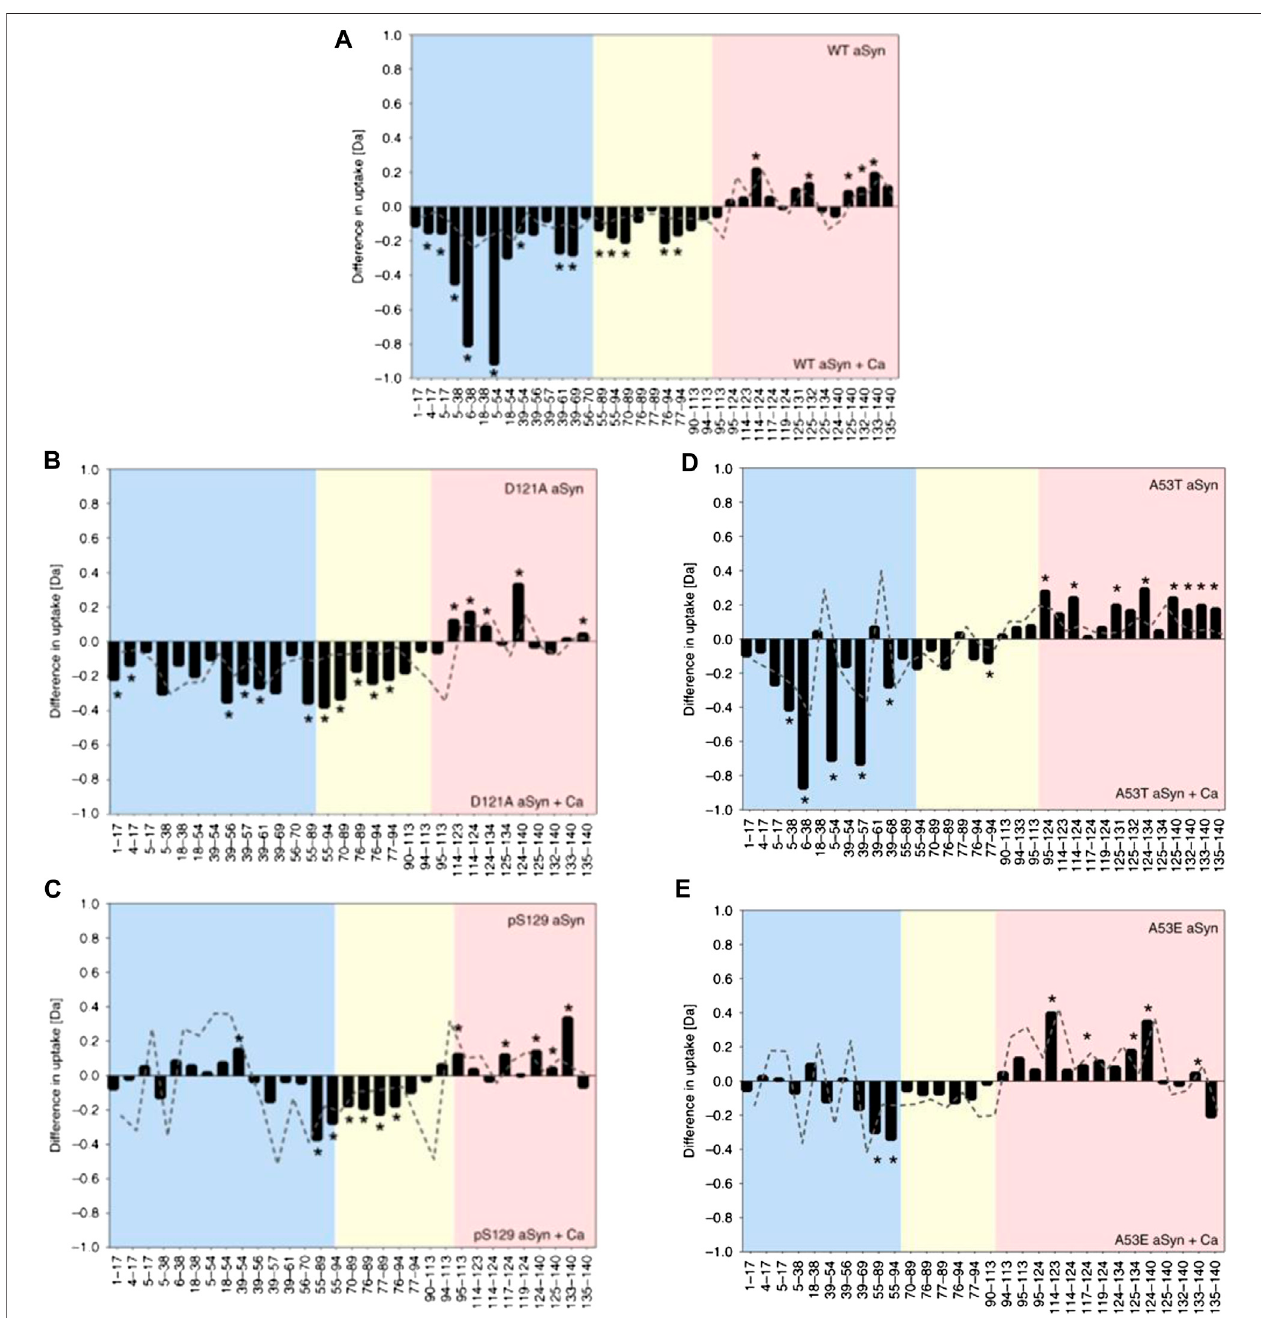
FIGURE4| HDX-MSrevealsdifferentialresponsesofaSynvariantstocalciumbinding.DifferentialdeuteriumuptakebetweenaSynintheabsenceandpresenceof added calcium for WT aSyn (A) , variants D121A (B) , and pS129 (C) and familial mutations A53T (D) and A53E (E) . The N-terminus is colored blue, the NAC yellow, and C-terminus red. Negative values represent increased deuterium uptake in the calcium-bound state, correlating to increased solvent exposure and lower hydrogen bonding. Positive values represent decreased deuterium uptake in the presence of calcium. The start and end of each peptide is marked on the x -axis. Figure adapted from (Stephens et al., 2020).